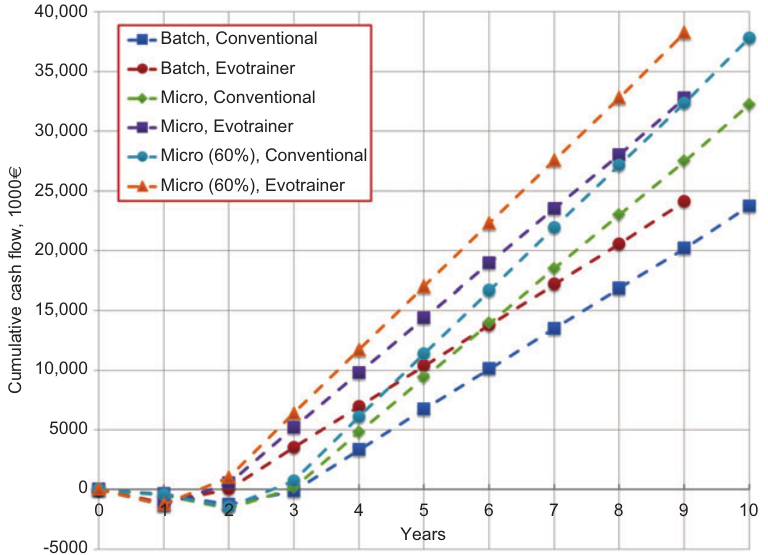
Figure 5 Cumulative cash flow diagram for the six cases considered (all 200 t/a; fine-chemical